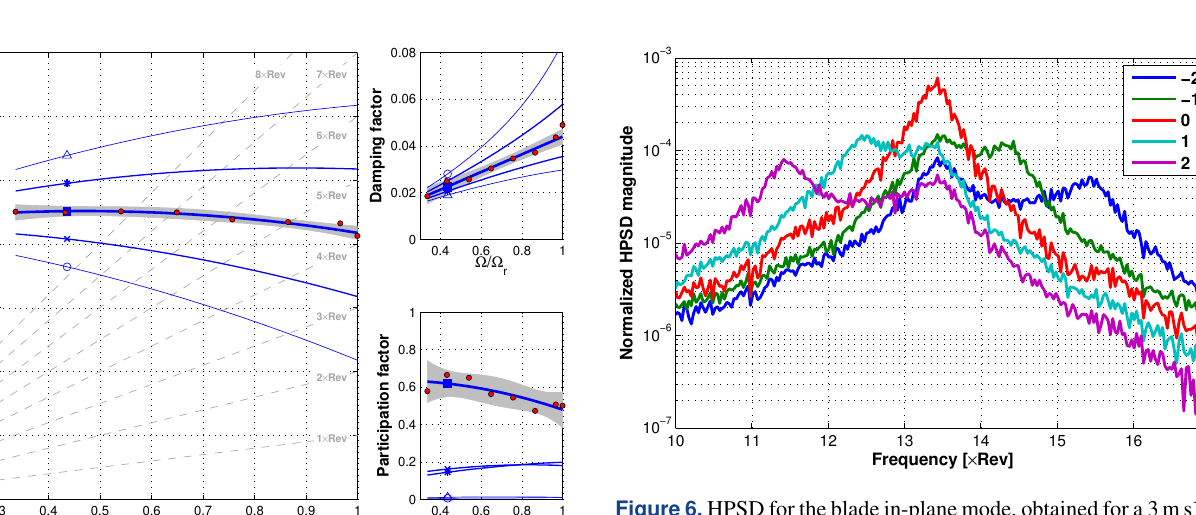
Figure 6. HPSD for the blade in-plane mode, obtained for a 3ms − 1 average wind